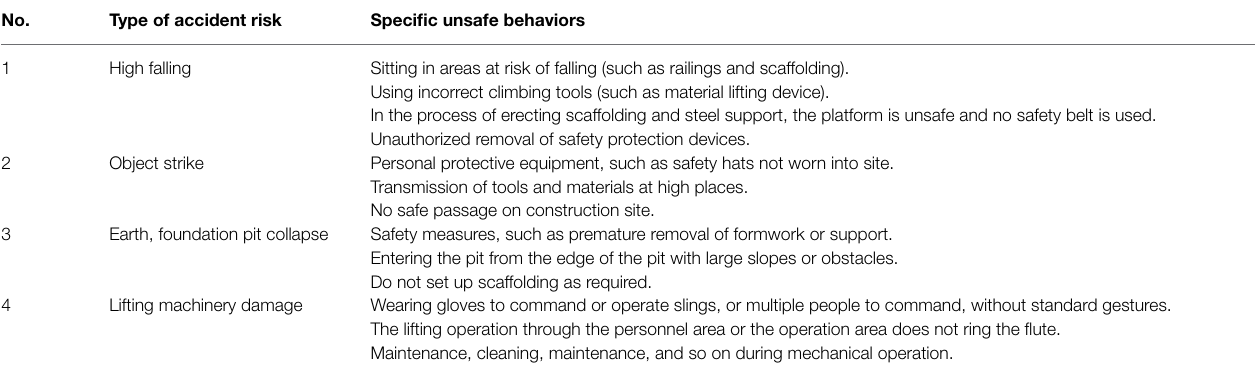
TABLE 1 | Safety observation scale for Construction Worker